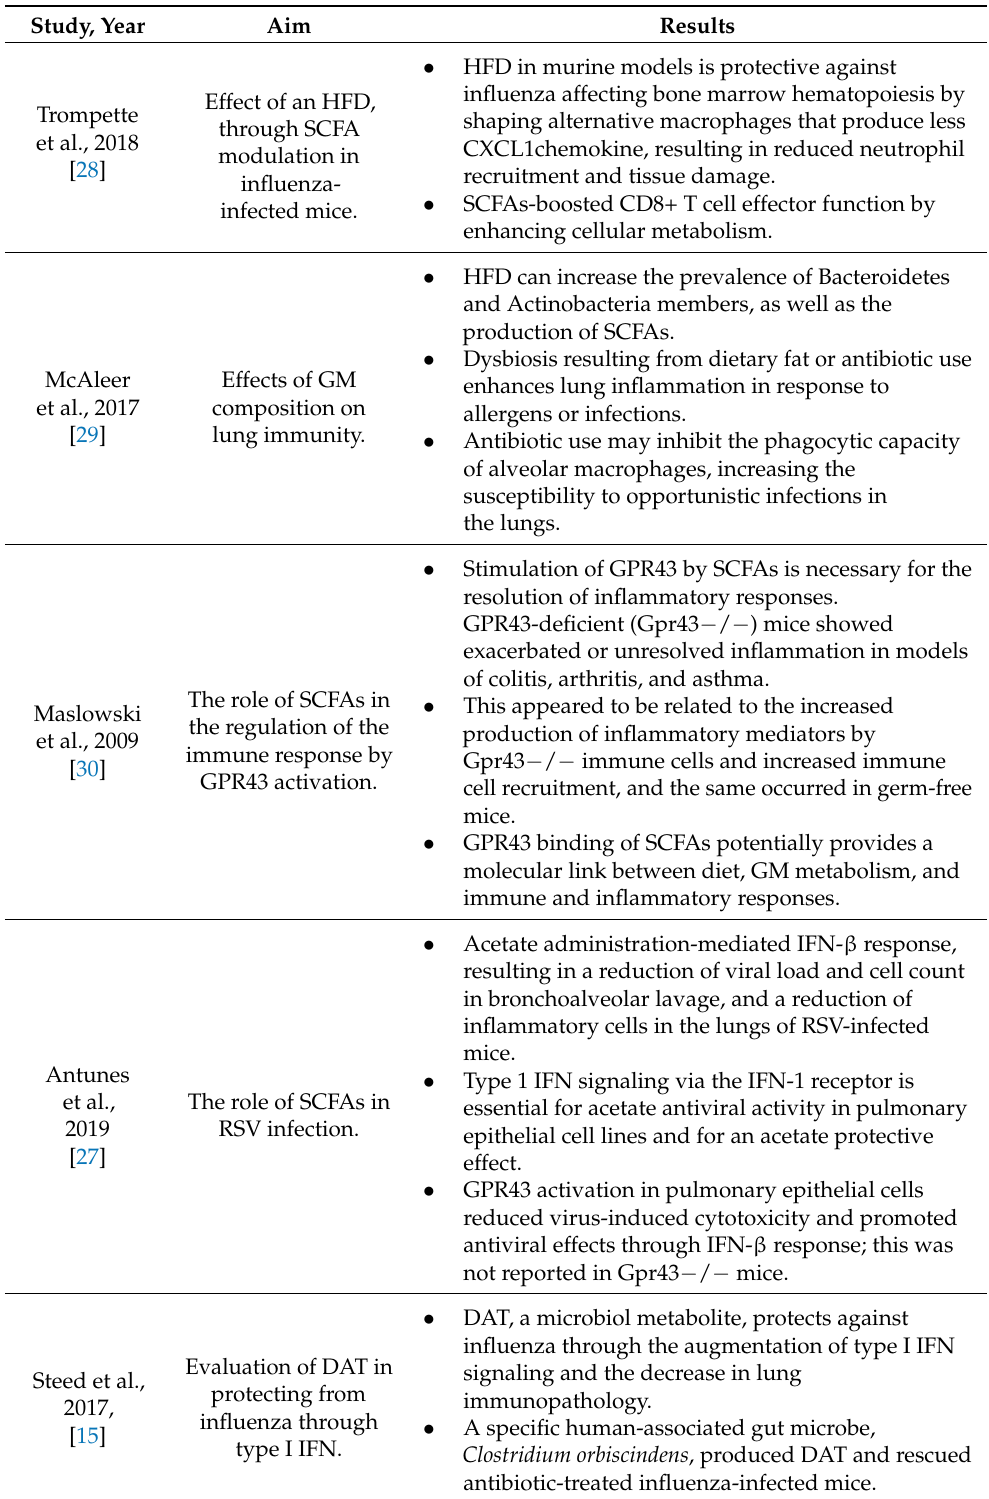
Table 1. Studies exploring the mechanisms through which the gut microbiota interacts with the lungs and affects the response to